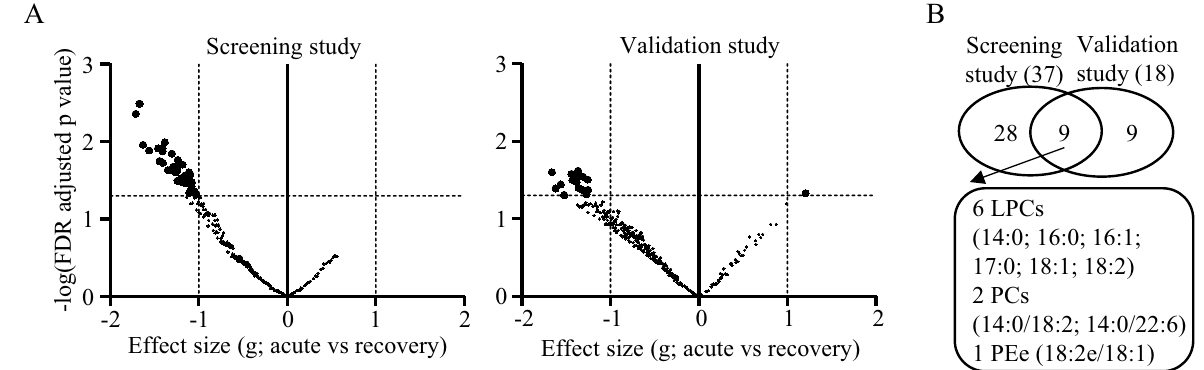
Figure 1. Lipidomics screening of candidate DILD biomarkers. ( A ) Individual lipid plot of false discovery rate (FDR) and effect size (g) from lipidomics analyses comparing acute and recovery phase DILD patients. ( B ) Venn diagram of significantly different lipids between acute and recovery phase DILD patients from the screening and validation